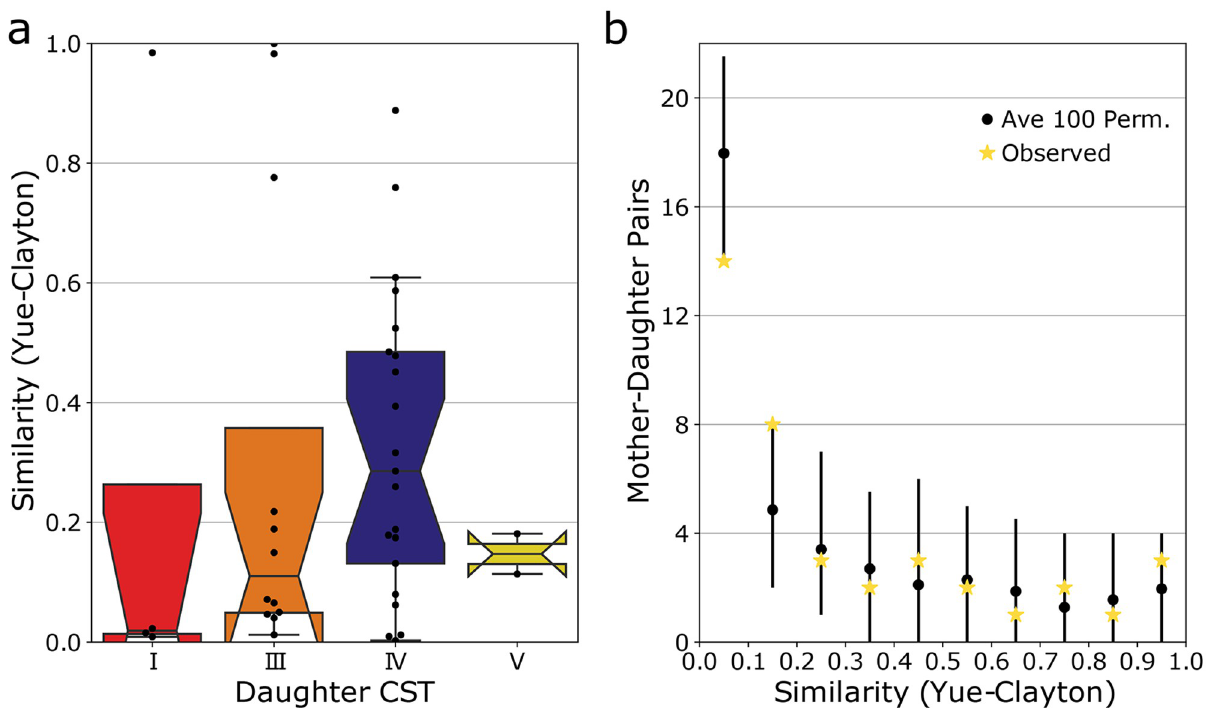
Fig 2. Similarity in the taxonomic composition between mother-daughter pairs, delineated by the daughter’s CST assignment (A). Higher values of the Yue-Clayton index signify communities that bear greater taxonomic compositional similarity. Permutation tests were used to establish whether the observed similarities between mothers and their daughters were different than that expected by chance alone (B). Black points represent the average number of permuted mother-daughter pairs whose similarity fell within 0.1 increments of the Yue-Clayton similarity index, while yellow stars represent the observed number of pairs. Error bars span the range between the 2.5% and 97.5% quantiles of the 100 random